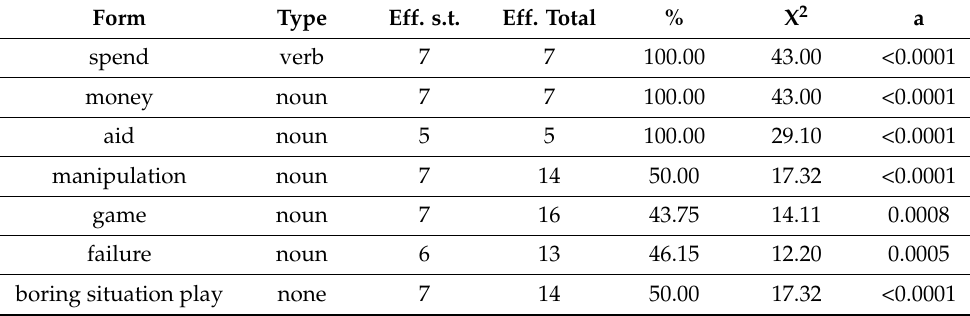
Table 6. More frequent words in class 6: Situations that upset when